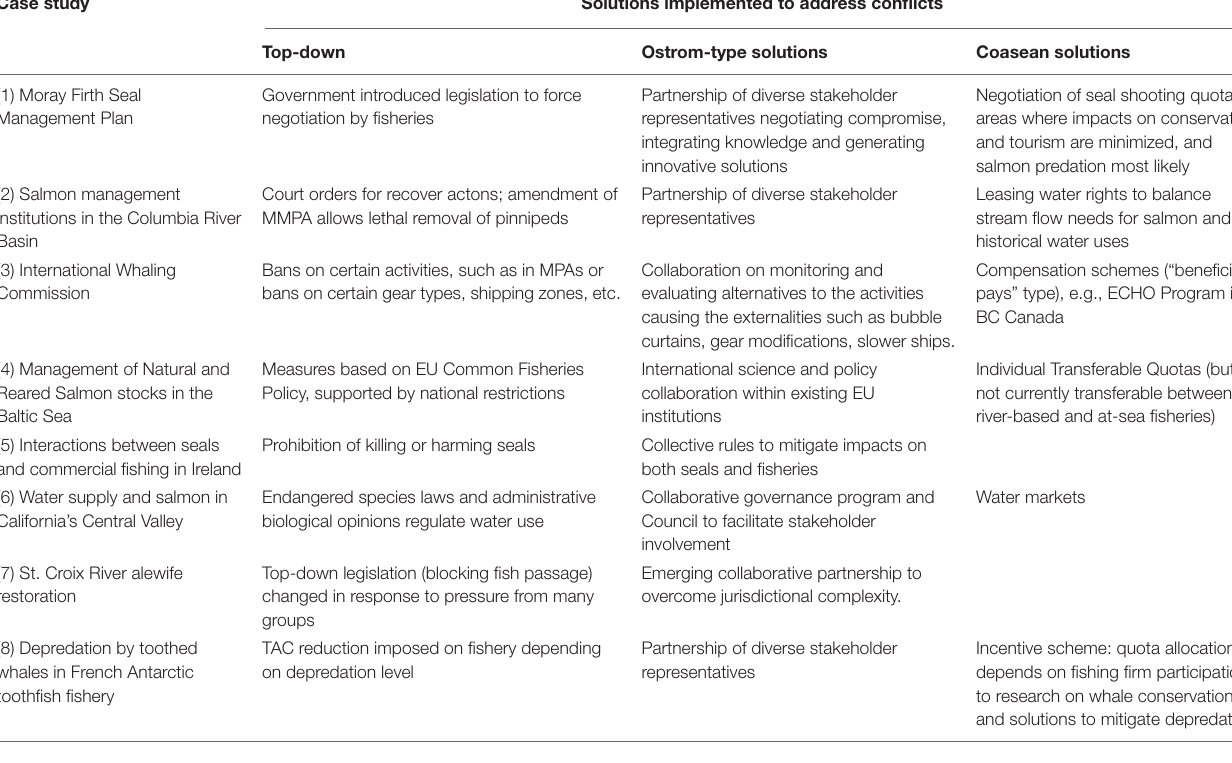
TABLE 7 | Case studies – Solutions implemented.